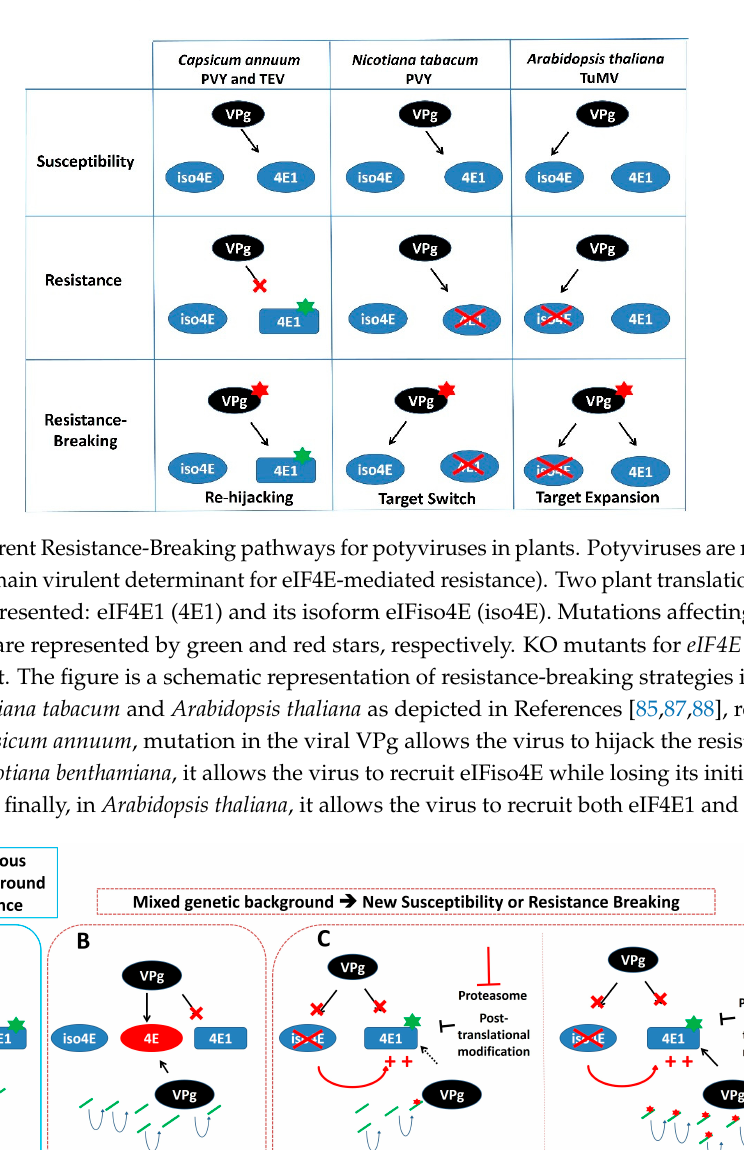
Figure 2. Different Resistance-Breaking pathways for potyviruses in plants. Potyviruses are represented by their VPg (main virulent determinant for eIF4E-mediated resistance). Two plant translation initiation factors are represented: eIF4E1 (4E1) and its isoform eIFiso4E (iso4E). Mutations affecting eIF4E1 or the viral VPg are represented by green and red stars, respectively. KO mutants for eIF4E or eIFiso4E are crossed out. The figure is a schematic representation of resistance-breaking strategies in Capsicum annuum , Nicotiana tabacum and Arabidopsis thaliana as depicted in References [85,87,88], respectively. Briefly, in Capsicum annuum , mutation in the viral VPg allows the virus to hijack the resistant eIF4E1 protein; in Nicotiana benthamiana , it allows the virus to recruit eIFiso4E while losing its initial ability to recruit eIF4E1; finally, in Arabidopsis thaliana , it allows the virus to recruit both eIF4E1 and eIFiso4E.